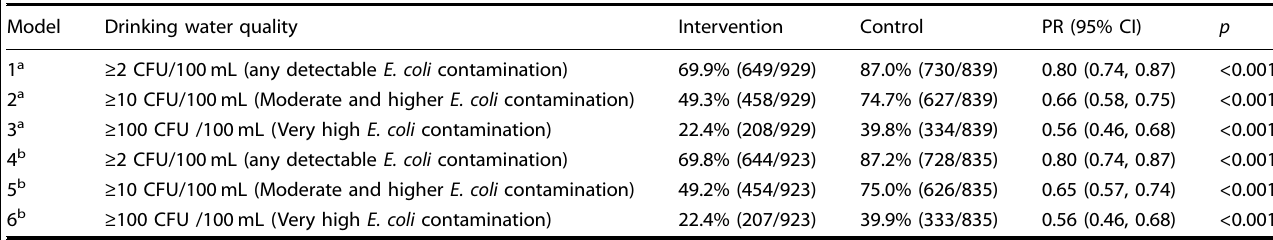
Table 3. Effects of intervention during follow-up on household-level drinking water quality outcomes.